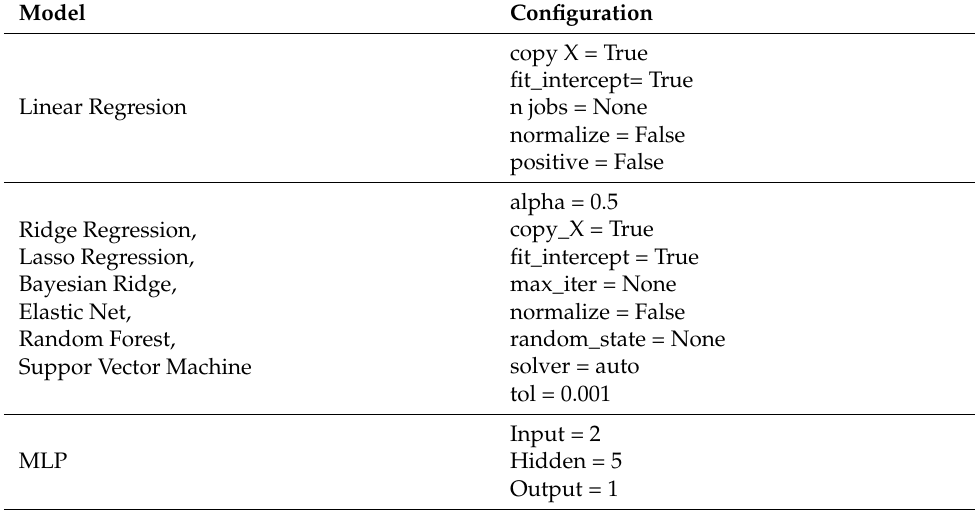
Table 3. Parameters.